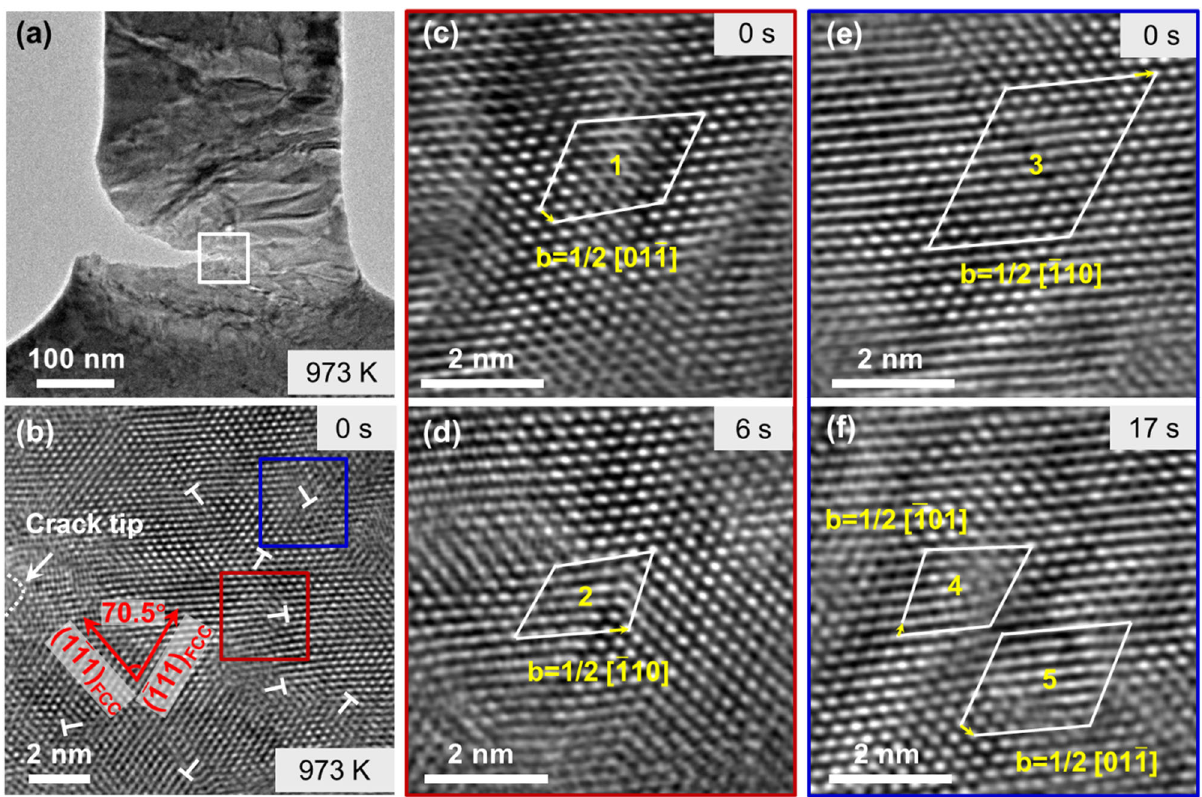
Fig. 5 TEM analysis of dislocation activities within the FCC phase region. a A TEM bright- fi eld image of a crack formed at 973 K. b A HRTEM image of the region within the white box in a in front of the crack tip. The entire region is in FCC structure in [110] normal orientation. c and d HRTEM images of the area identi fi ed by the red box in b at a higher magni fi cation. The two images were taken in situ during straining. The 1/2[011] dislocation seen in c evolved into 1/2[110] dislocation after straining. e and f HRTEM images of the area identi fi ed by the blue box in b at a higher magni fi cation. The two images were taken in situ during straining. The 1/2 [110] dislocation in e decomposed into 1/2 [101] and 1/2 [011] dislocations after further straining. NATURE COMMUNICATIONS| (2021) 12:2218